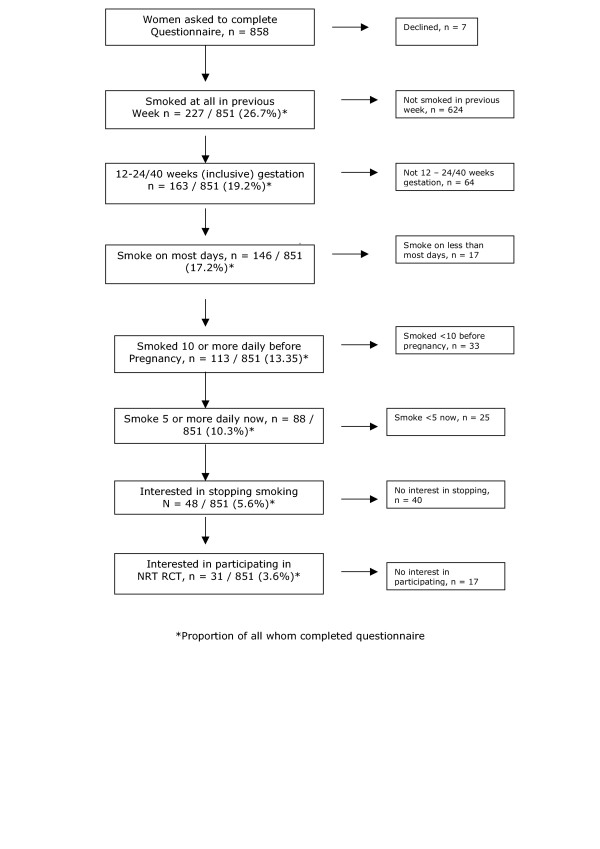
Flow Chart of Study Participation